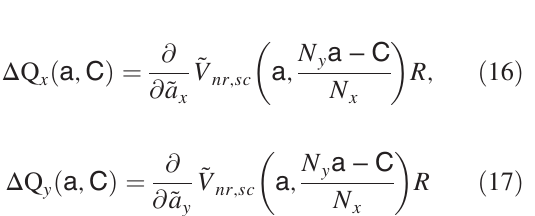
x ;n y ;j x ;j y − m